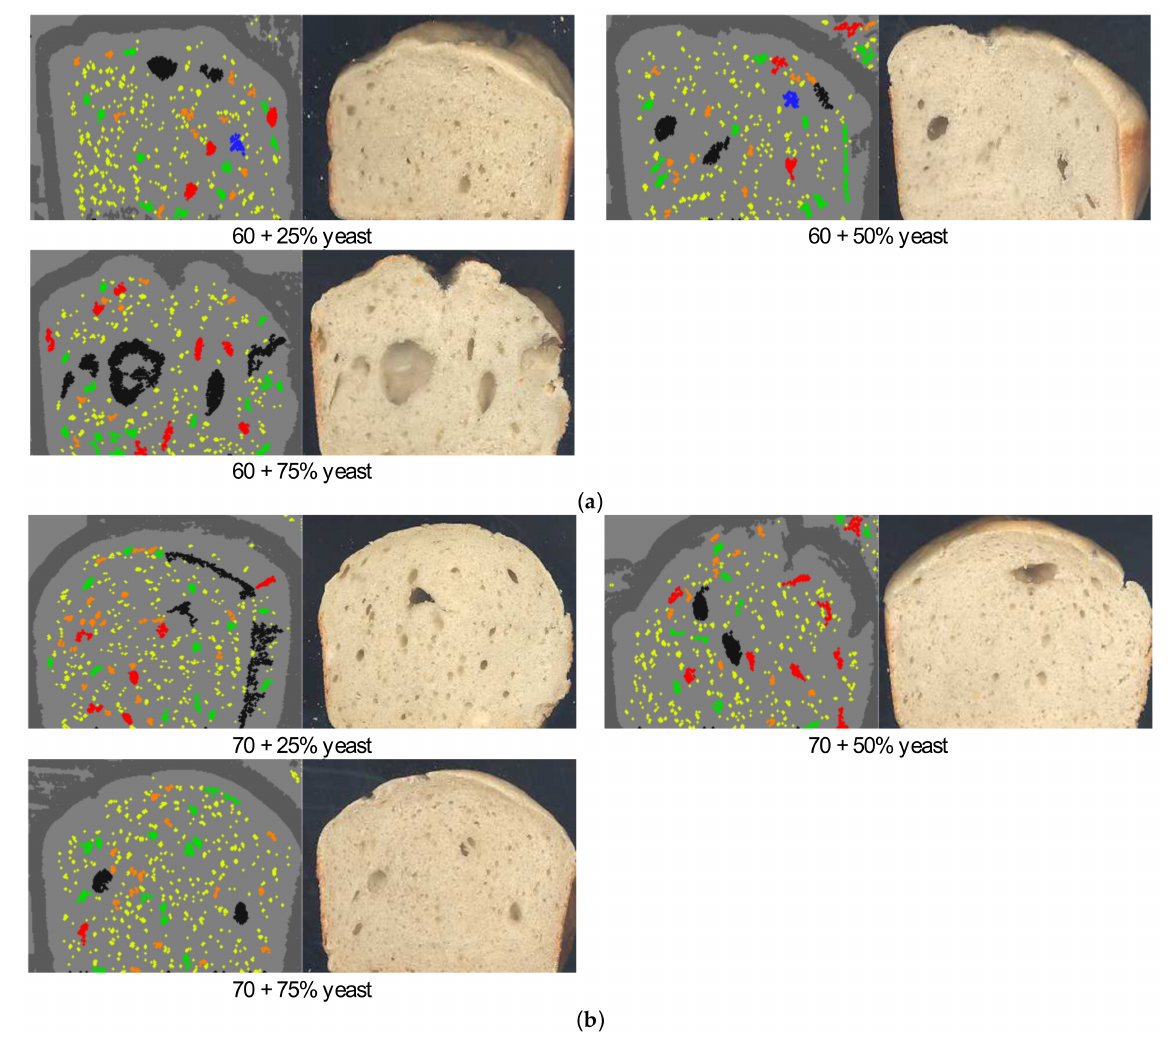
Figure 5. Pore size analysis of ( a ) 60% and ( b ) 70% GH breads with promoters and 25–75% yeast as partial replacement. The figure shows that there was improvement in the bread pores when the cross-sectional image was